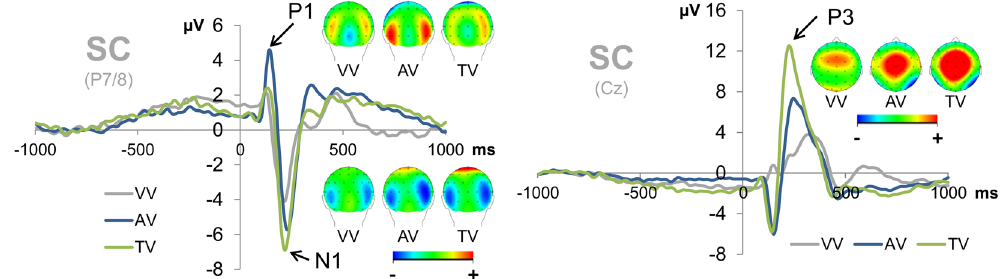
Figure 3. Event-related potentials. LEFT: Effects of task version on early attentional stimulus processing as reflected by the visual P1 and N1 components at electrodes P7 and P8. As can be seen, the amplitudes of the visually evoked P1 and N1 ERPs differed in case of simultaneous STOP-CHANGE stimulus presentation. While the P1 amplitude was increased only by the AV task version, the N1 was increased by both the AV and TV task versions, with the latter yielding the largest amplitude. VV = visual task version, AV = audio-visual task version, TV = tactile-visual task version. Topography maps are provided for each task and peak. RIGHT: Effects of task version on the central P3 component at electrode Cz. After simultaneous STOP-CHANGE stimulus presentation, the unimodal VV task version yielded the smallest P3 amplitudes, followed by the bimodal AV and TV task versions (with all three tasks significantly differing from each other). VV = visual task version, AV = audio-visual task version, TV = tactile-visual task version. Topography maps are provided for each task and